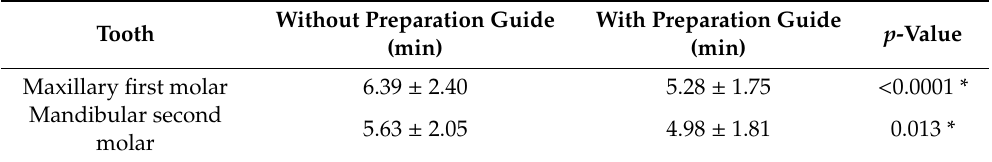
Table 1. Time taken for tooth preparation.